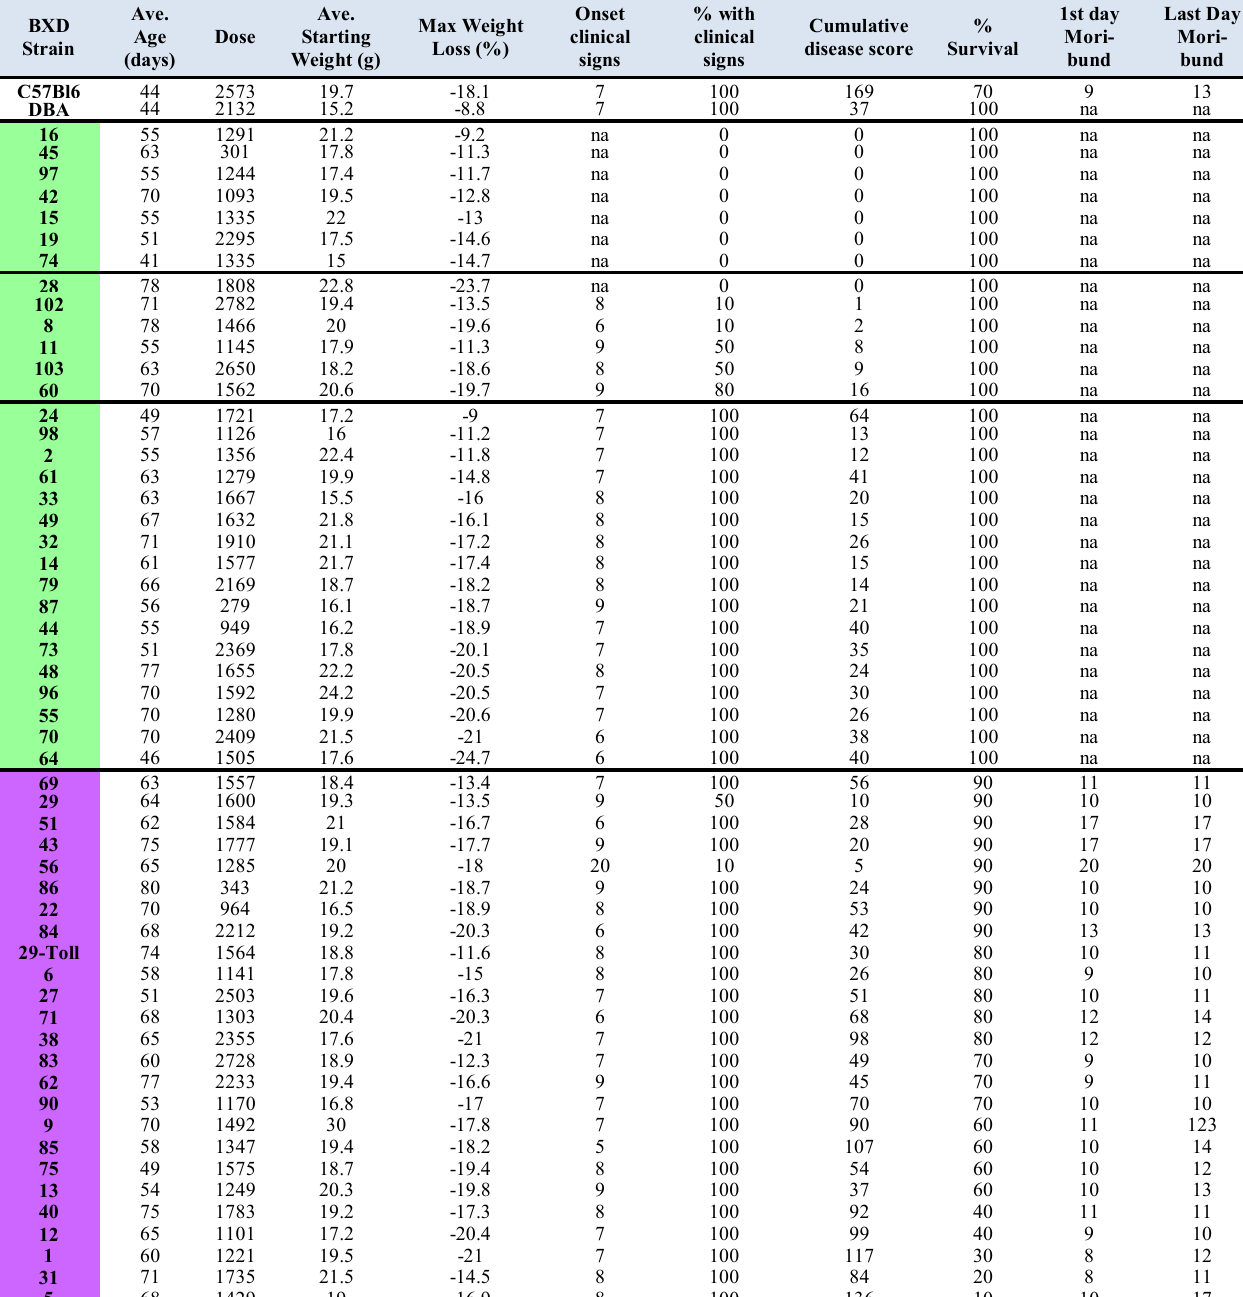
Table 1. BXD strains exposed to a high dose of aerosolized MA-EBOV. BXD strains fell into three groups based on the percent lethality following exposure to 1608 ± 549 pfu airborne MA-EBOV: resistant (green), intermediate (purple) and susceptible (orange). Within each group, strains were ordered by survival (if applicable), % of animals displaying clinical signs and % weight loss. Data presented are: average age of mice, aerosol dose, average starting weight, maximum % weight loss when all mice from group living, day of onset of clinical signs, % of mice with clinical signs, cumulative disease score, % survival, and first and last days animal became moribund ( n =